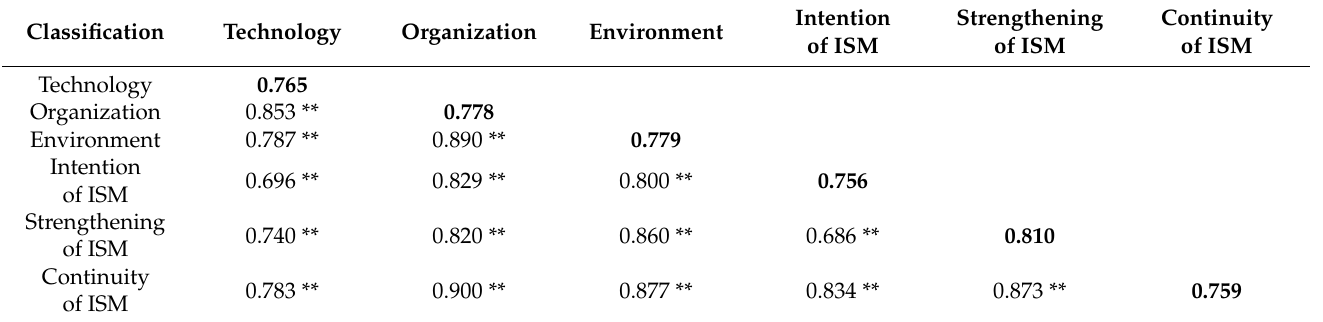
Table 4. Correlation matrix and